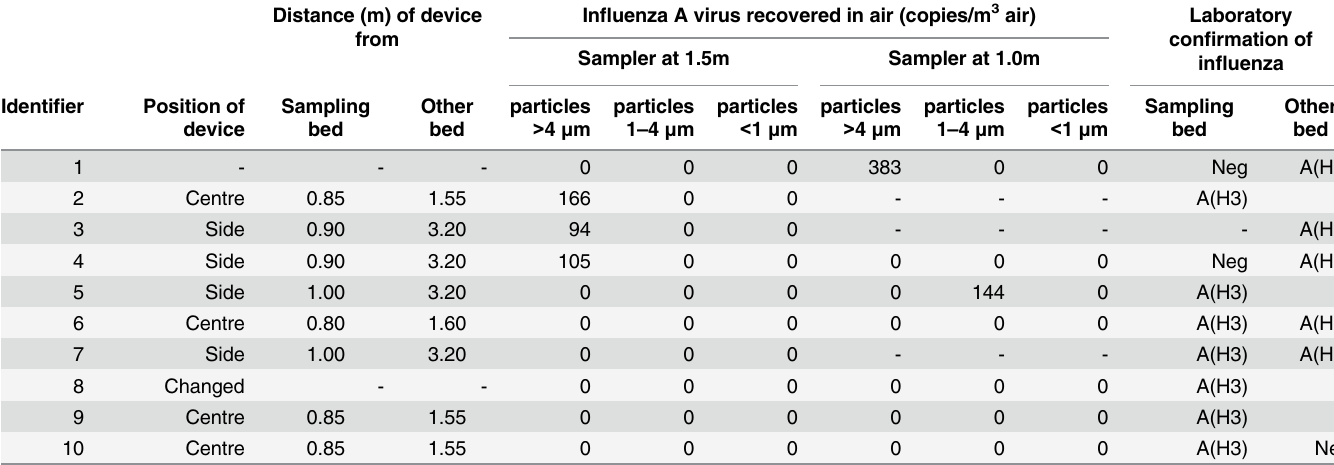
Table 1. Recovery of influenza A virus RNA in air in 2-bed inpatient rooms with at least one patient with laboratory-confirmed influenza A virus infection. Distance (m) of device